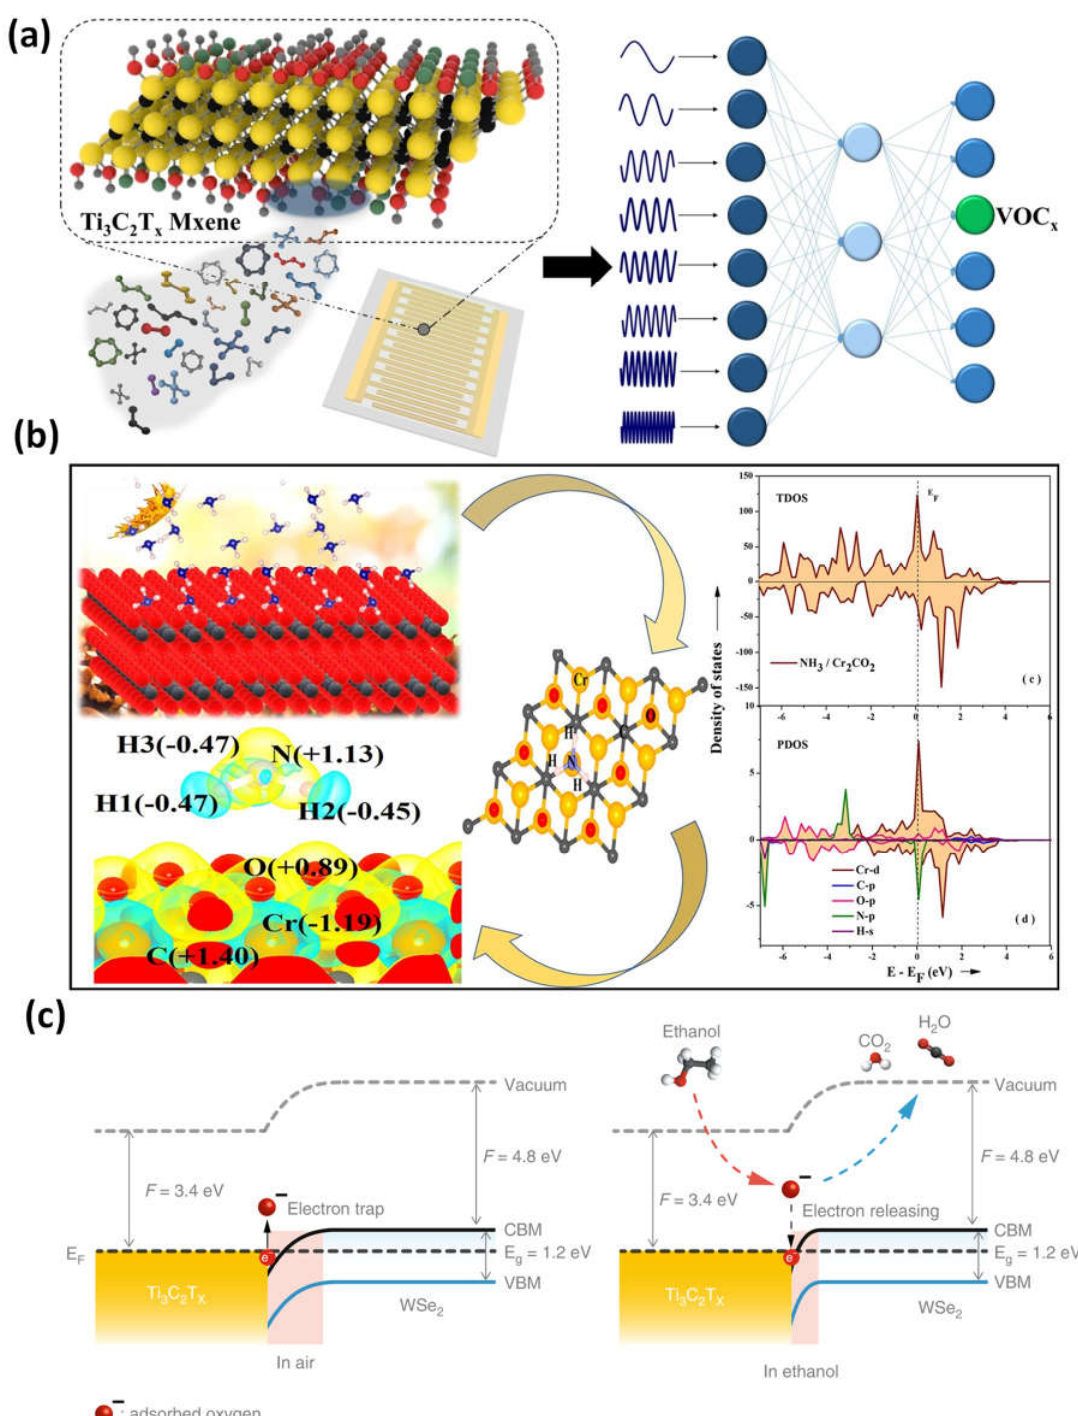
Figure 5. ( a ) The virtual sensor array of MXene 2D material for the ethanol detection in the presence of various concentrations of methanol and water; ( b ) simulation of 2D layered Transition-metal carbide and calculations for NH 3 gas detection; ( c ) Ti 3 C 2 T x /WSe 2 energy-band graph in air and ethanol, illustrating the change in the depletion region caused by the interaction of adsorbed oxygen species and ethanol molecules. Reproduced with permission from references [49,54,55].